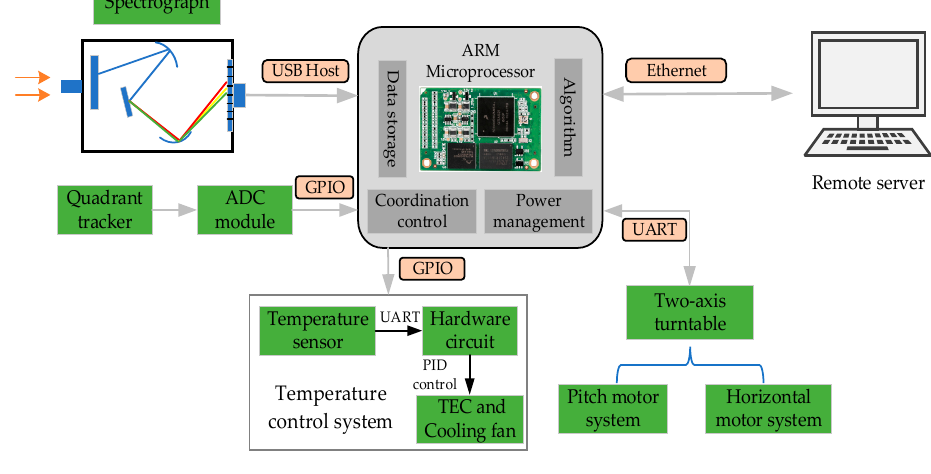
Figure 4. Architecture diagram of embedded platform.